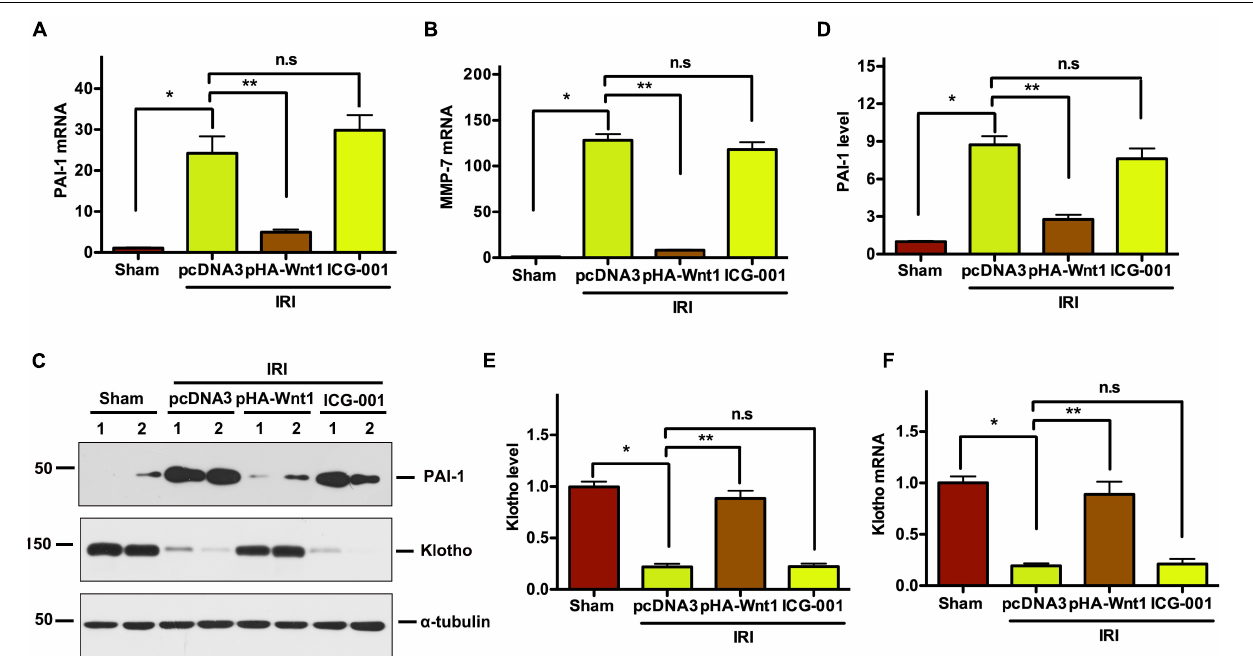
FIGURE 5 | In vivo expression of exogenous Wnt1 before IR downregulates renal Wnt/ β -catenin target genes in mice after AKI-CKD progression. (A,B) mRNA expression of PAI-1 and MMP-7 in different groups as indicated. (C–E) Representative Western blot analyses of PAI-1 and Klotho protein levels. (F) mRNA expression of Klotho. * P < 0.05; ** P < 0.01. n = 5.